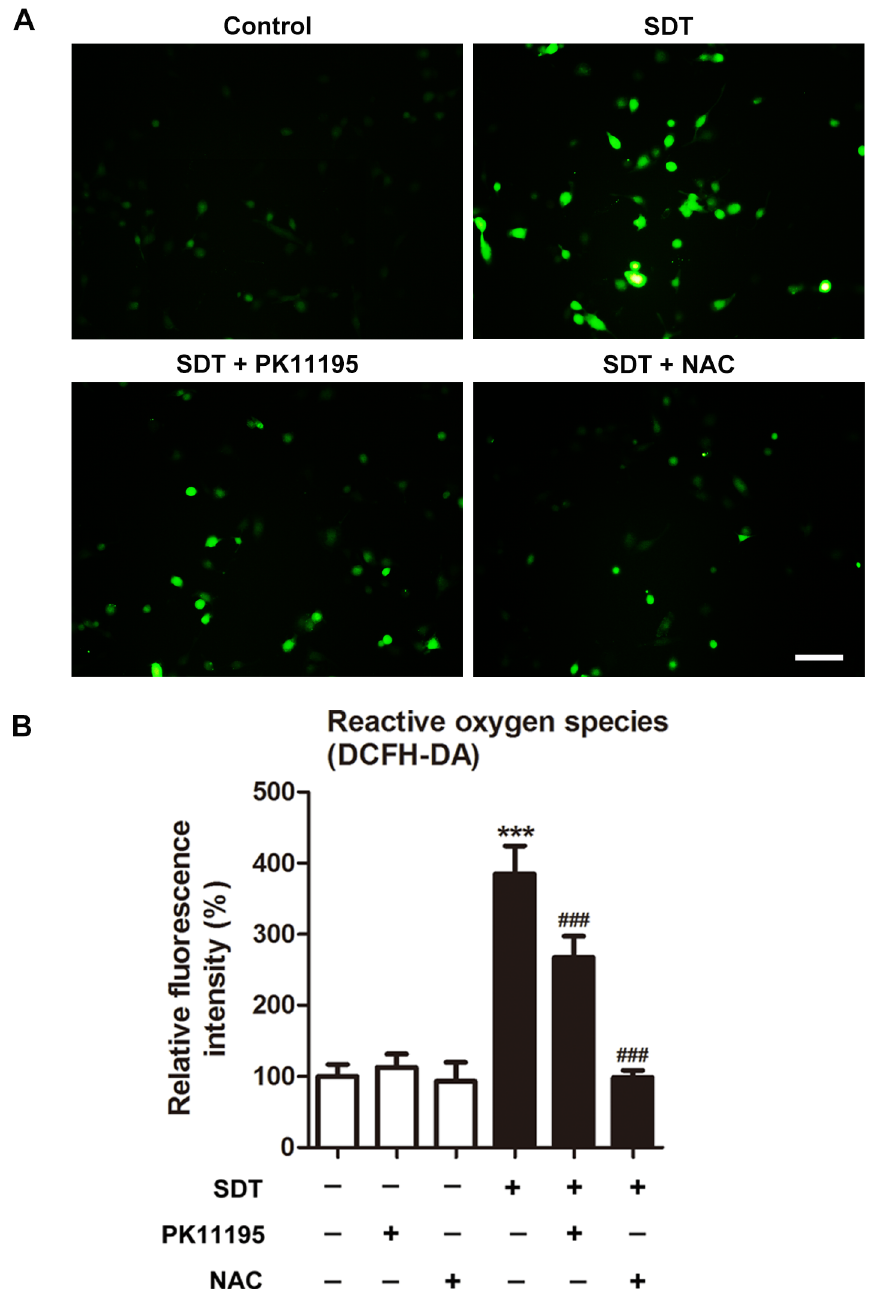
Fig 2. Effects of PK 11195 and NAC on SDT-induced ROS generation using the dye DCFH-DA. THP-1 macrophages were treated with 5-aminolevulinic acid mediated sonodynamic therapy (ALA-SDT), with or without pretreatment of PK 11195 or NAC. (A) Immediately after treatment, ROS production in THP-1 macrophages was observed under fluorescence microscope. The ALA-SDT treated cells showed increased green fluorescence level of ROS as compared with the untreated controls, and this effect was inhibited by adding PK 11195 or NAC before sonication. Scar bar: 0.1 mm. (B) Fluorescence intensity of ROS was measured using fluorospectrophotometer. (cid:3)(cid:3)(cid:3) P < 0.001 compared to no treatment group, ### P < 0.001 compared to ALA-SDT treated group.